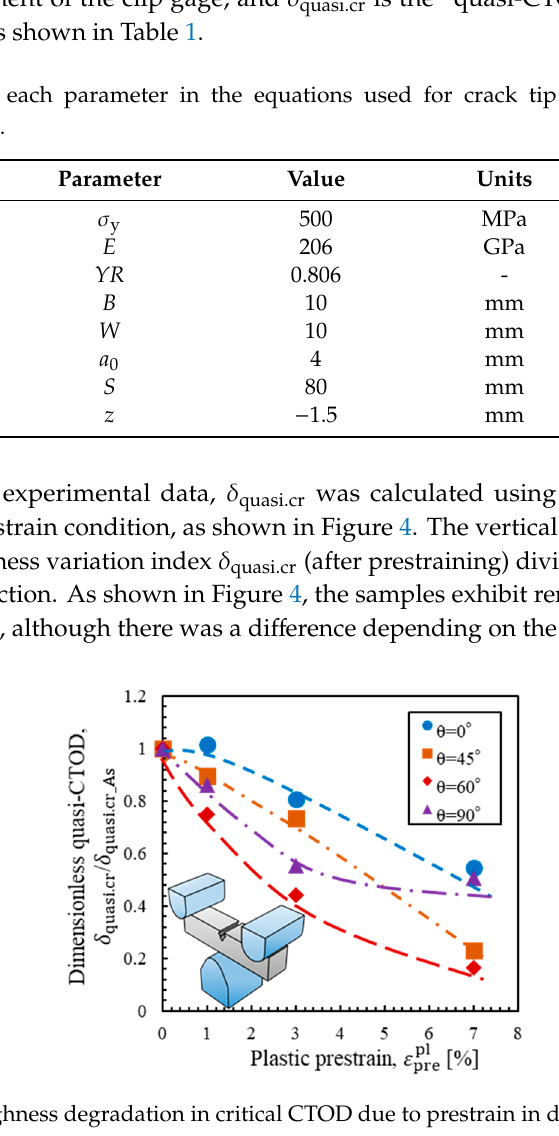
Figure 4. Toughness degradation in critical CTOD due to prestrain in different directions.